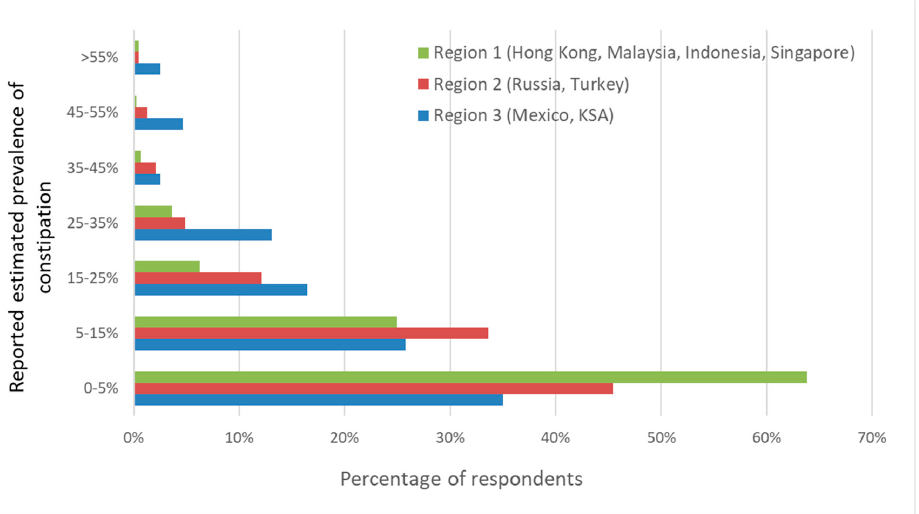
Figure 5. The estimated reported prevalence of FC in infants by region (in %). Overall, there are significant differences in the distribution of estimated prevalence between regions ( p <